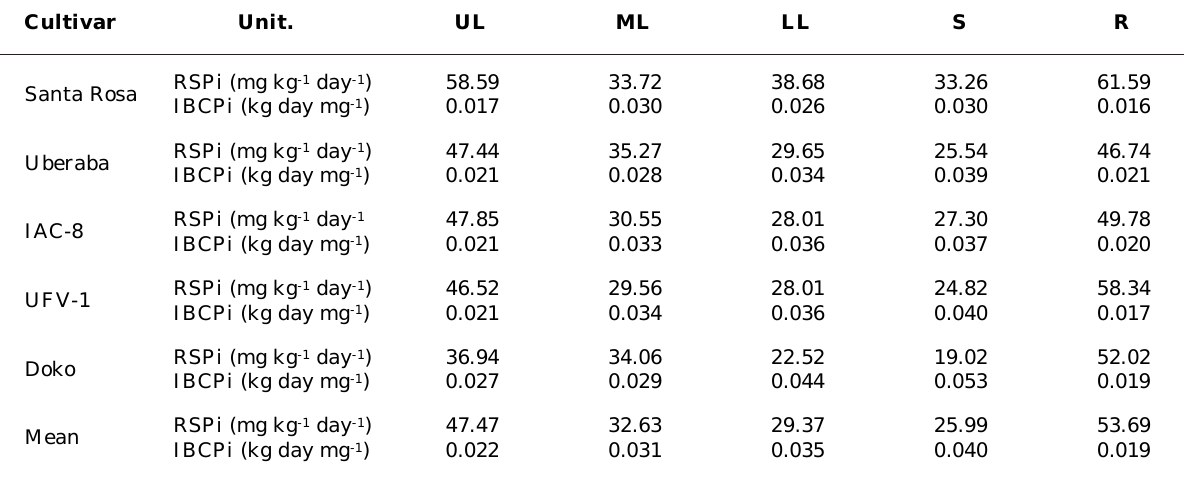
Table 2. Inorganic phosphorus release velocity (RSPi) and internal Pi buffering capacity (IBCPi) in upper (UL), midlle (ML) and lower leaves (LL), stems (S), and roots (R) of soybean plants cultivated in nutrient